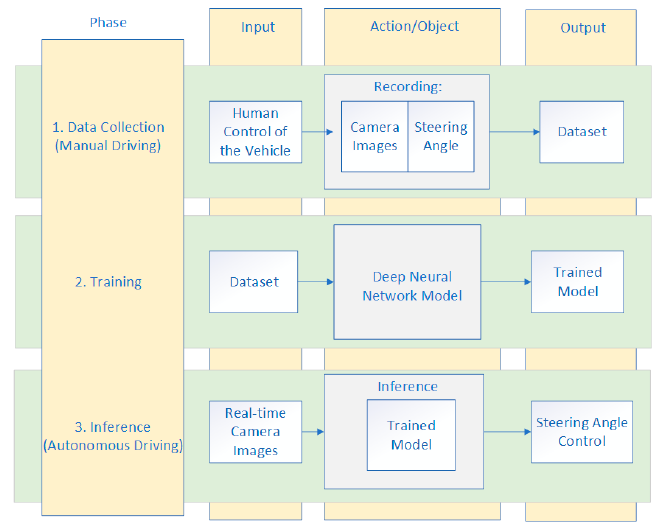
Figure 5. Block diagram of the autonomous driving framework.